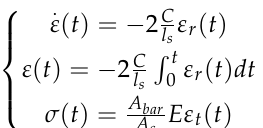
Figure 4. Schematic diagram of the SHPB experimental setup. The SHPB experimental technique is based on two basic assumptions: the one-dimensional stress assumption and the homogeneity assumption. Applying the one-dimensional stress wave theory, the force–displacement curve at the interface between the compression bar and the specimen can be obtained from the strain signal. Based on the homogeneity assumption, the loading strain rate, strain, and stress of the material can be determined, which can be given by Equation (2). The specific theoretical calculation procedure for the SHPB can be found in Ref. [31].